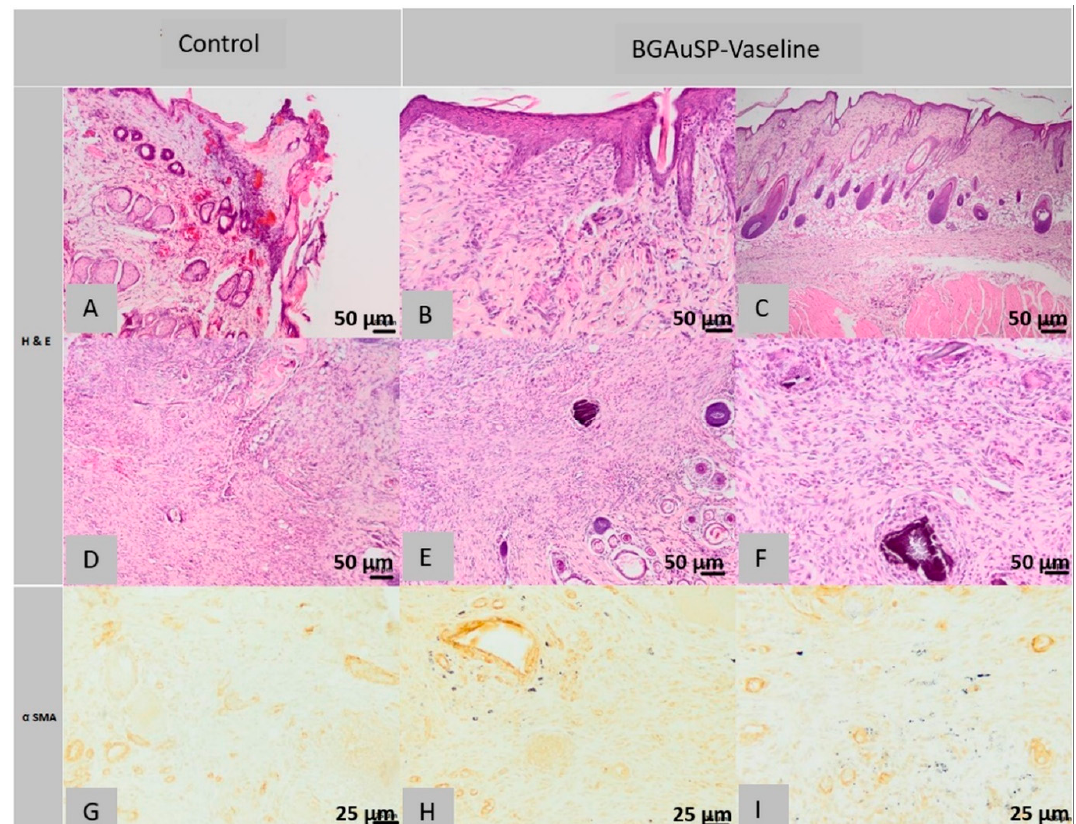
Figure 11. Histopathological images of the skin and subcutaneous tissue from the control animals from group BGAuSP- Vaseline: partially healed surgical wound ( A ), discontinuous epidermis in the process of regeneration ( A ), scar tissue contains few positive cells ( D ), fully cured surgical wound, partially regenerated pilosebaceous glands ( D ) (col. HE, ob. 40×), granulation formed by fusiform cells ( G ) (col. α SMA ob. 40×). Histopathological images of the skin and subcutaneous tissue from the animals treated with BGAuSP-Vaseline: the surgical wound was completely healed with excess granulation tissue containing multifocal granules of inert foreign body ( B ), granulation tissue formed by fusiform cells ( C ), in the deep dermis, numerous eosinophils are present with rare mast cells ( E ), the surgical wound completely healed with fibroblasts ( F ), (col. HE, ob. 40×) near the defect is interrupted and replaced with scar tissue infiltrated with rare mast cells ( H ) (col. Α SMA, ob. 40×), in the granulation tissue that replaces the dermis an Panniculus carnosus are fusiform (myofibroblast) positive α -SMA cells ( I ).